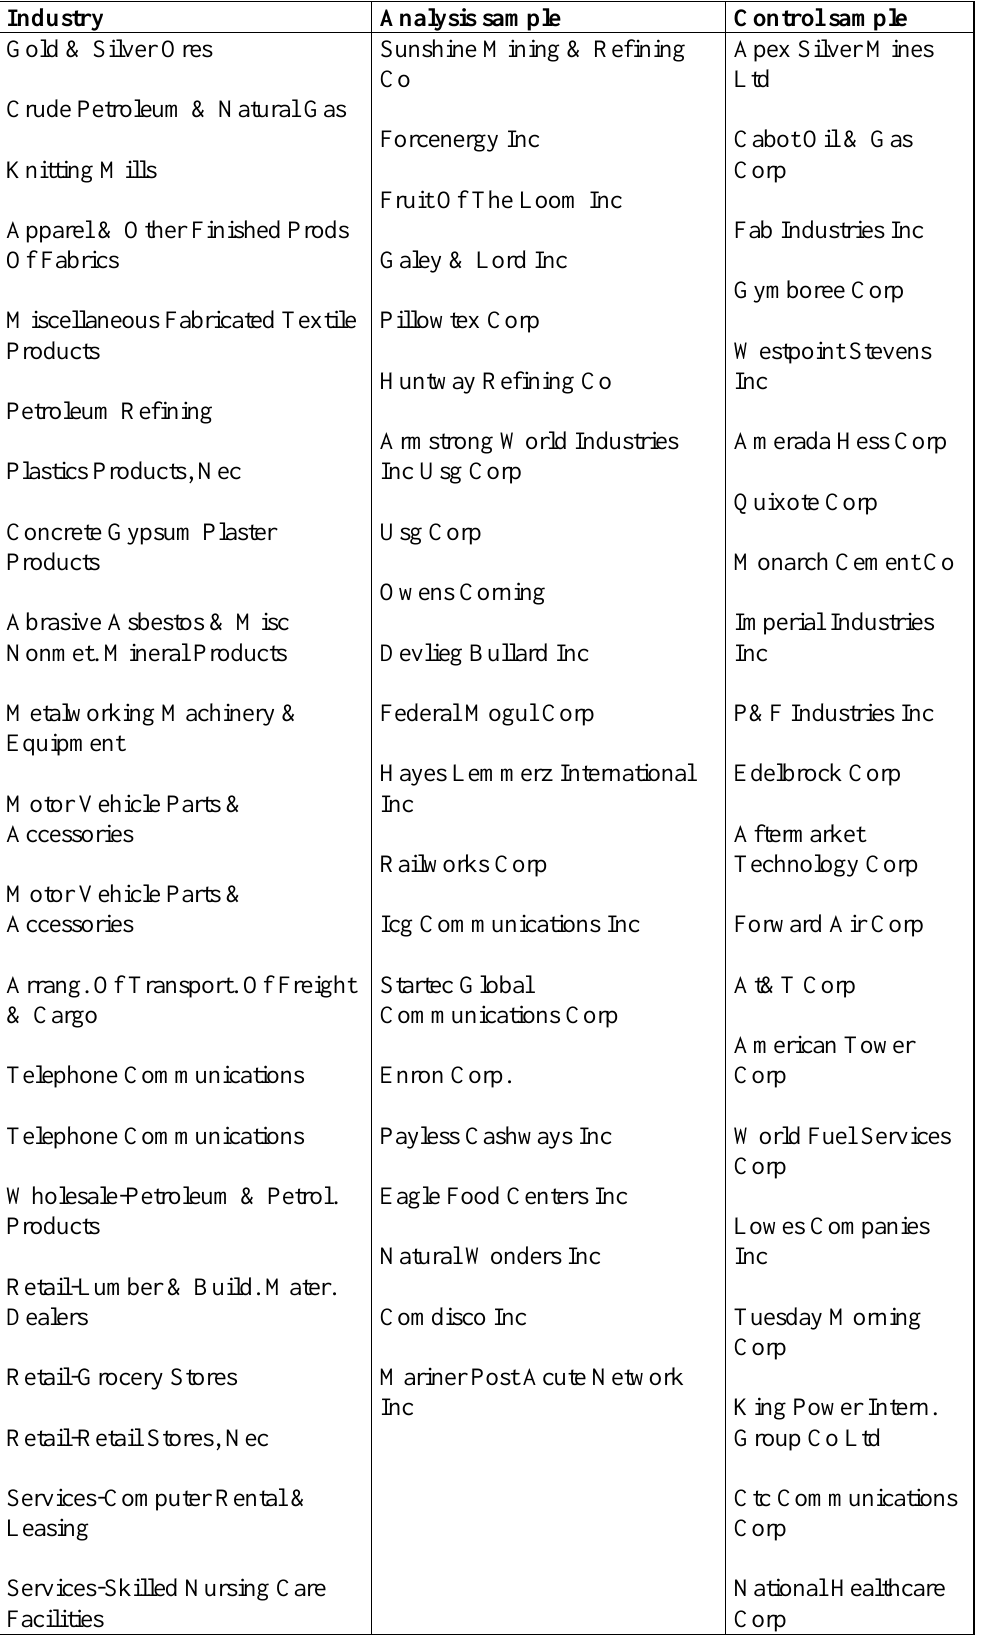
Table 1: The Sample Analysed Industry Analysis sample Control